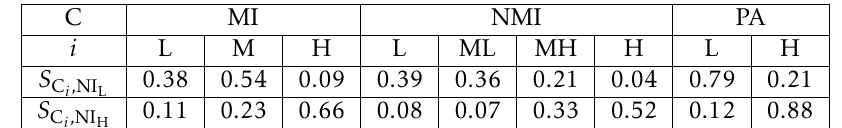
Figure 1. Distributions of participants to all 48 user profiles. Table 6. Similarity scores between the two NI clusters and the clusters under the other three nudging conditions, calculated according to Eq. (2) (C = nudging condition).